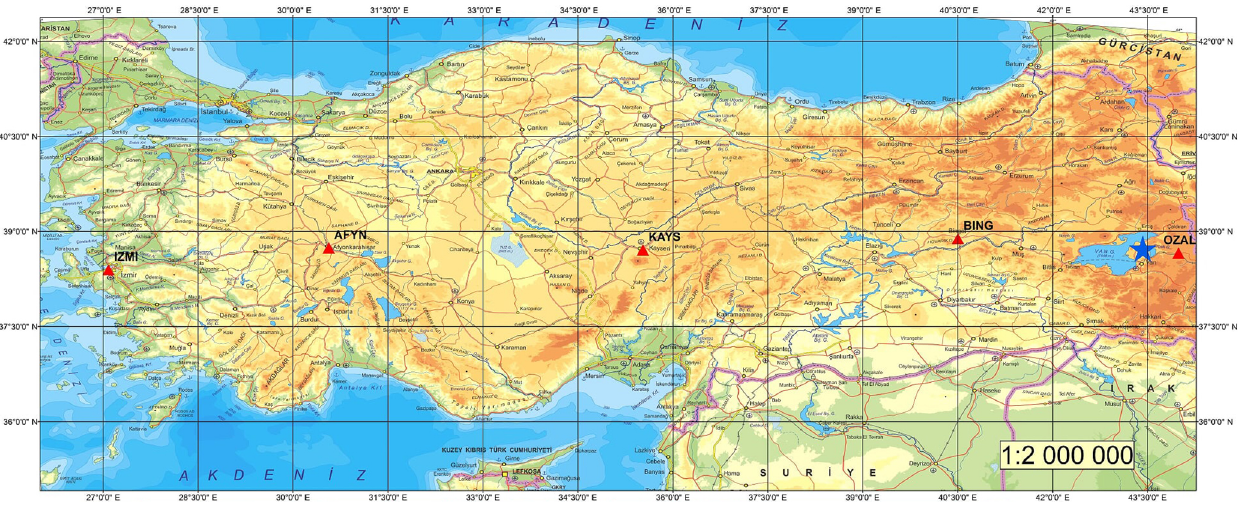
Figure 1. OZAL, IZMI, AFYN, KAYS and BING stations analyzed in the present